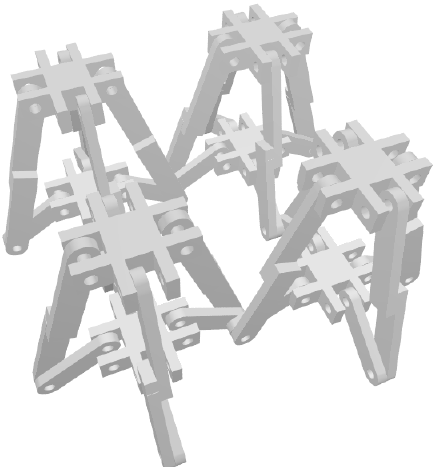
Figure A1. A diagram showing a system studied in this work made from a 2 × 2 × 1 assembly of structural